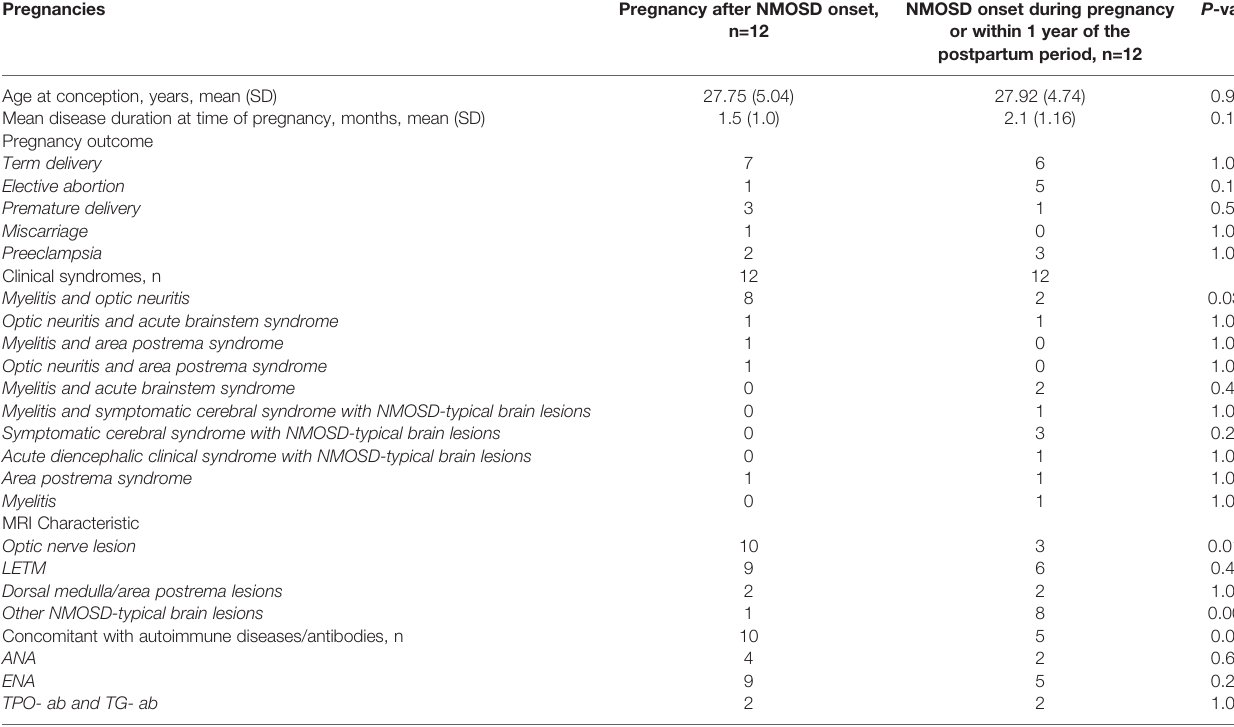
TABLE 1 | Demographic and clinical characteristics of patients with pregnancy-related NMOSD attacks.